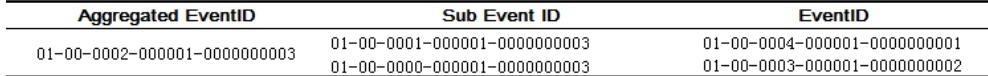
Figure 6. Suspect tracking of group incident Table 1. Group incident